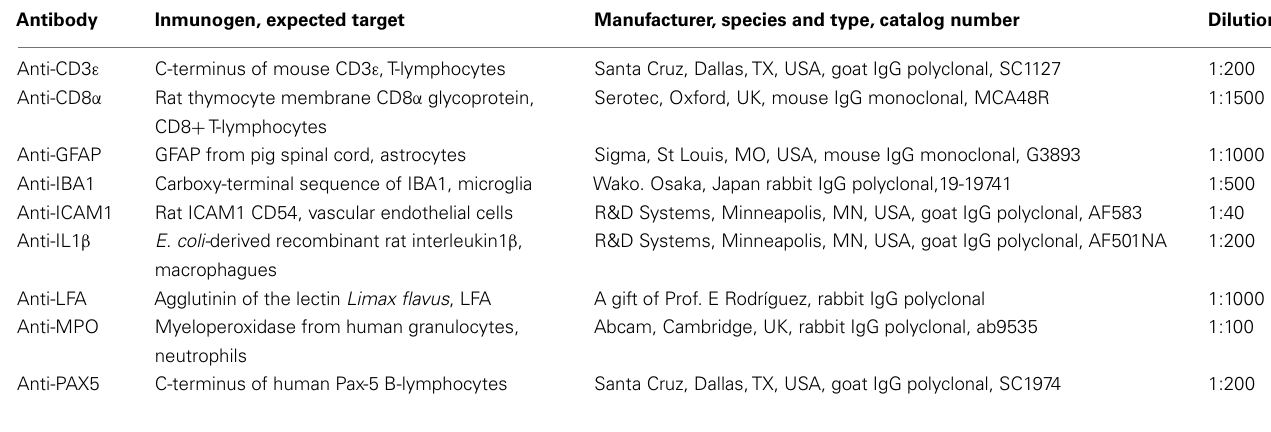
Table 1 | List of primary antibodies used for immunohistochemistry